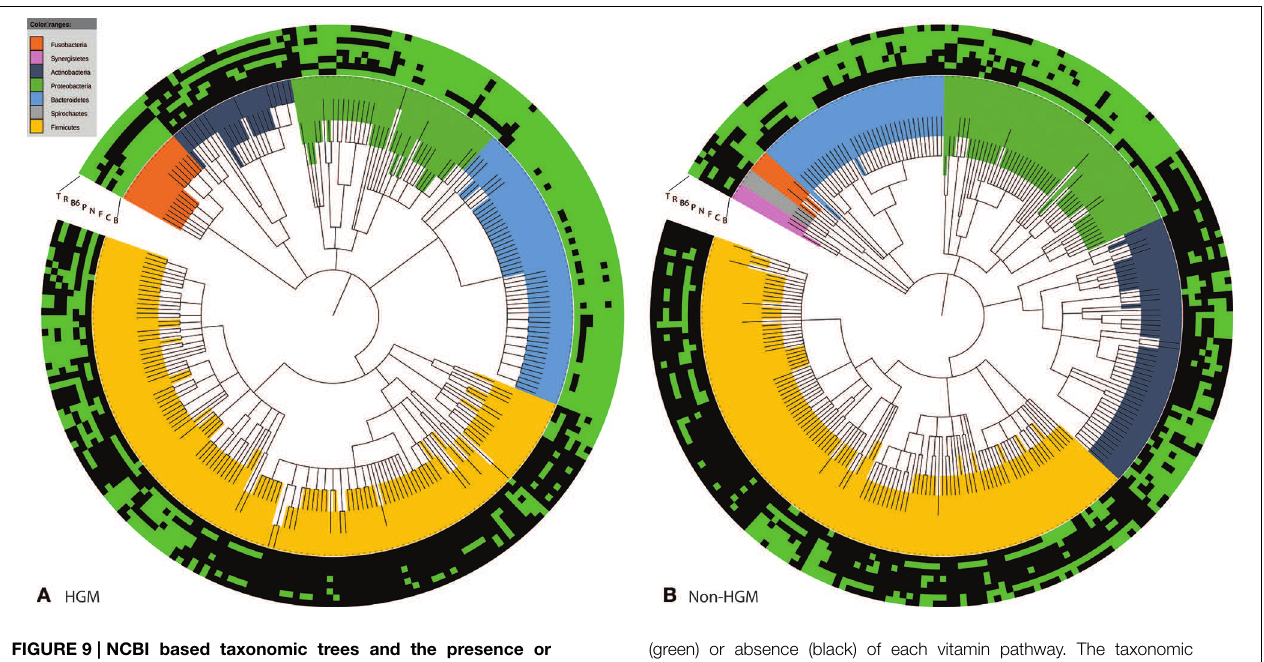
(green) or absence (black) of each vitamin pathway. The taxonomic trees were produced using PhyloT: a tree generator (http://phylot.biobyte.de/index.html), and visualized through iTOL (http://itol.embl.de/) (Letunic and Bork, 2007,